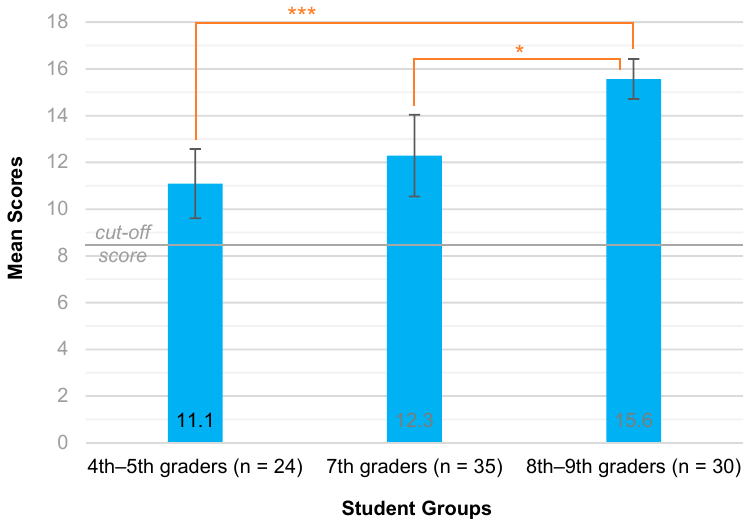
Figure 8. Mean total scores (out of 18) for the intervention and comparison groups. Error bars show 95% CI = Mean ± (1.96 SE). * p < 0.05, *** p < 0.001.